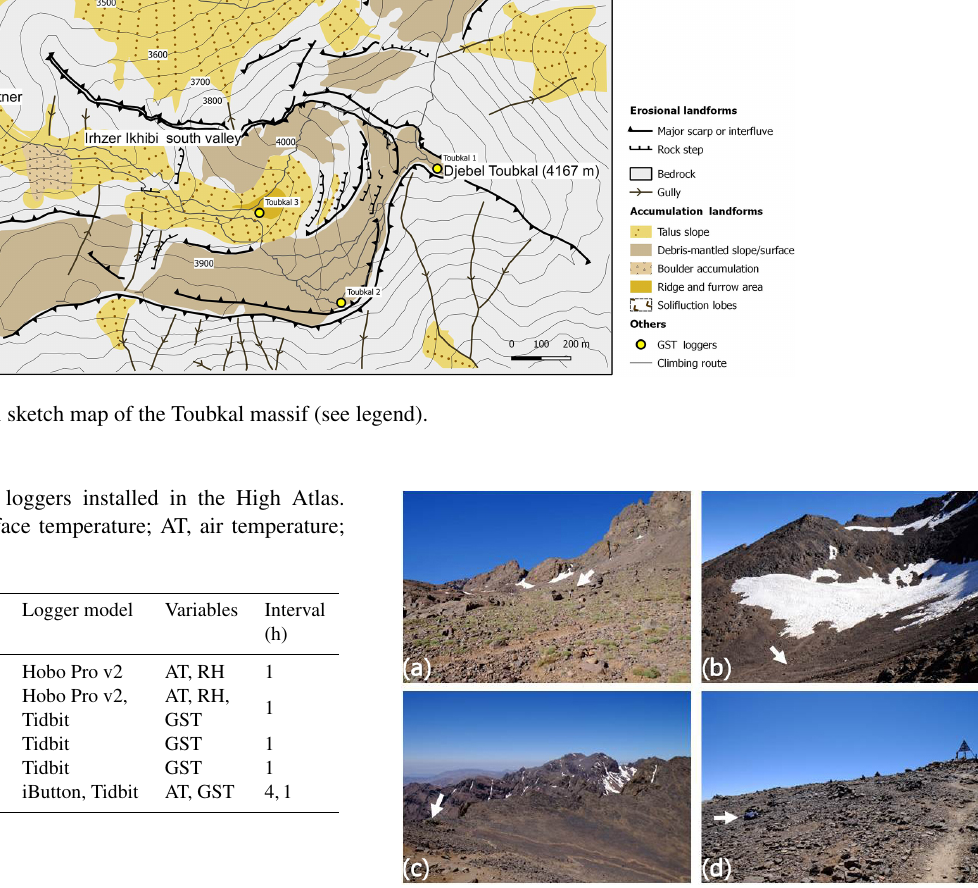
Figure 3. Locations of the ground surface temperature loggers (white arrows): (a) Neltner (3220m), (b) Toubkal 3 (3815m), (c) Toubkal 2 (3980m) and (d) Toubkal 1